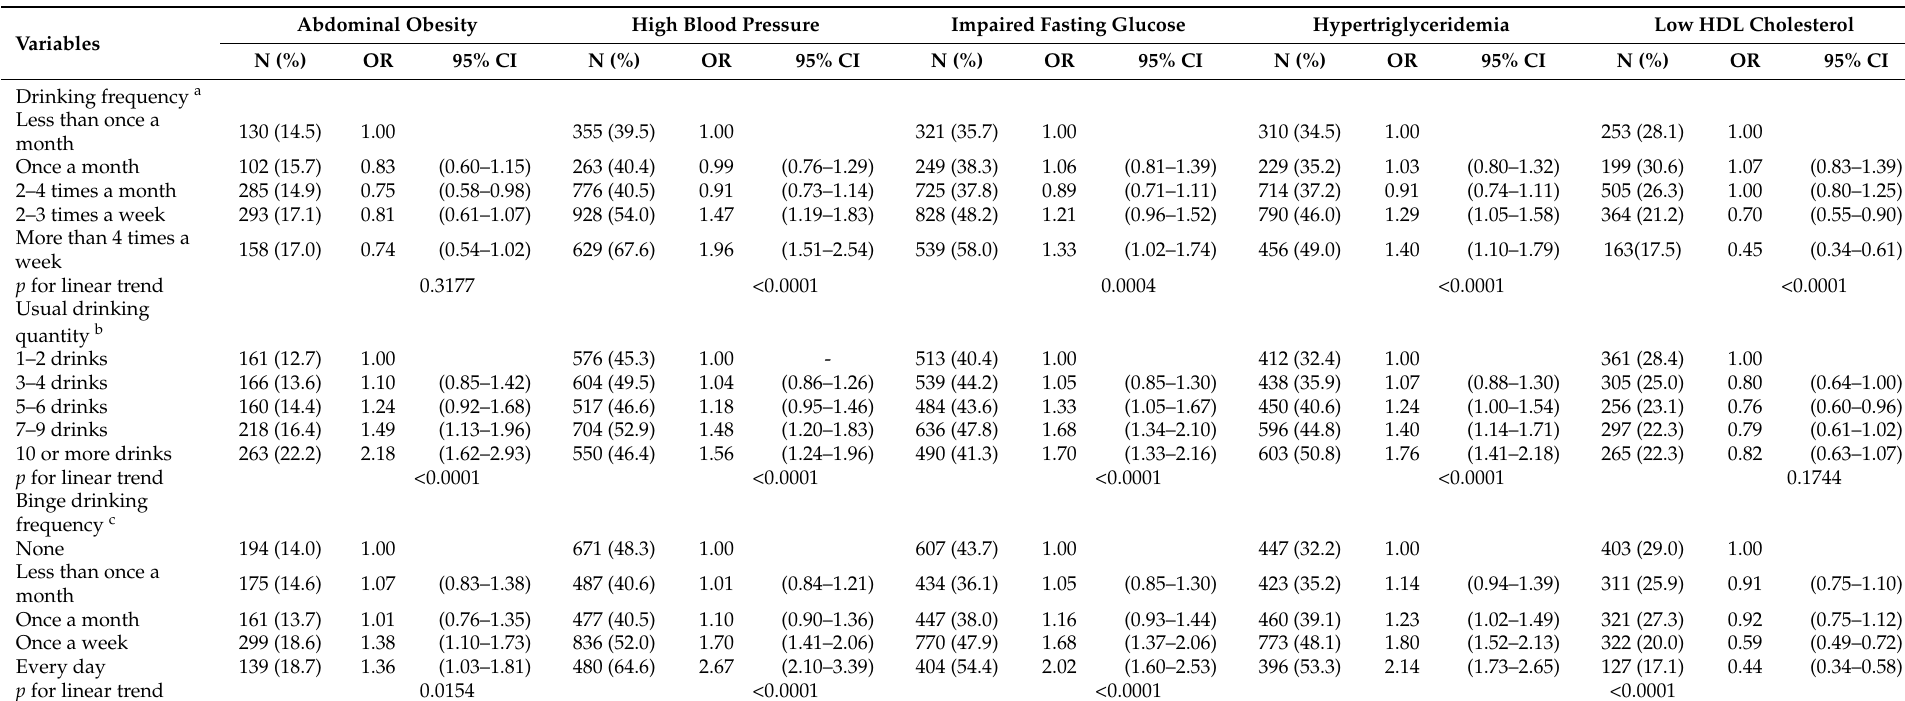
Table 3. The association between alcohol drinking patterns and components of metabolic syndrome in